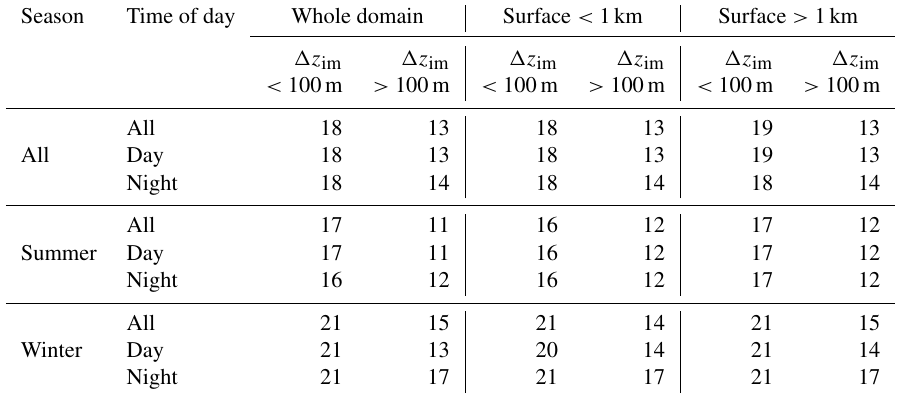
Table 3. (cid:49)z im seasonality: fraction (%) of (cid:49)z im smaller than 100m and larger than 100m in all measurements with the specified surface height, for summer vs. winter and day vs. night (Julian days ≥ 106 and < 289 are summer, hours ≥ 6 and < 18 are days). In total, 31% of the measurements contain both a cirrus and a mixed-phase cloud. (cid:49)z im values up to 12km in length were evaluated.